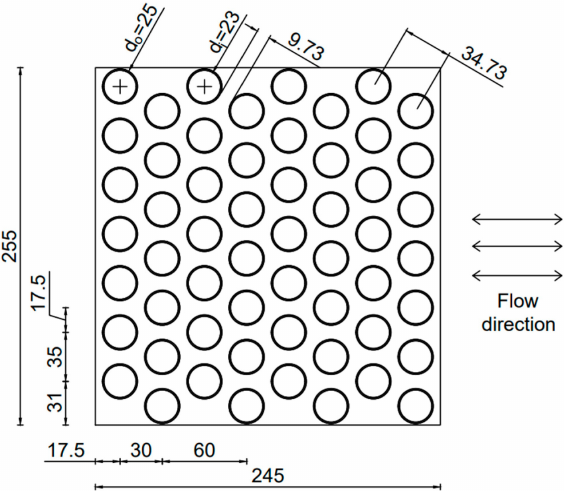
Figure 9. Design of cylinder system with an external diameter of 25 mm in heat exchanger 2.